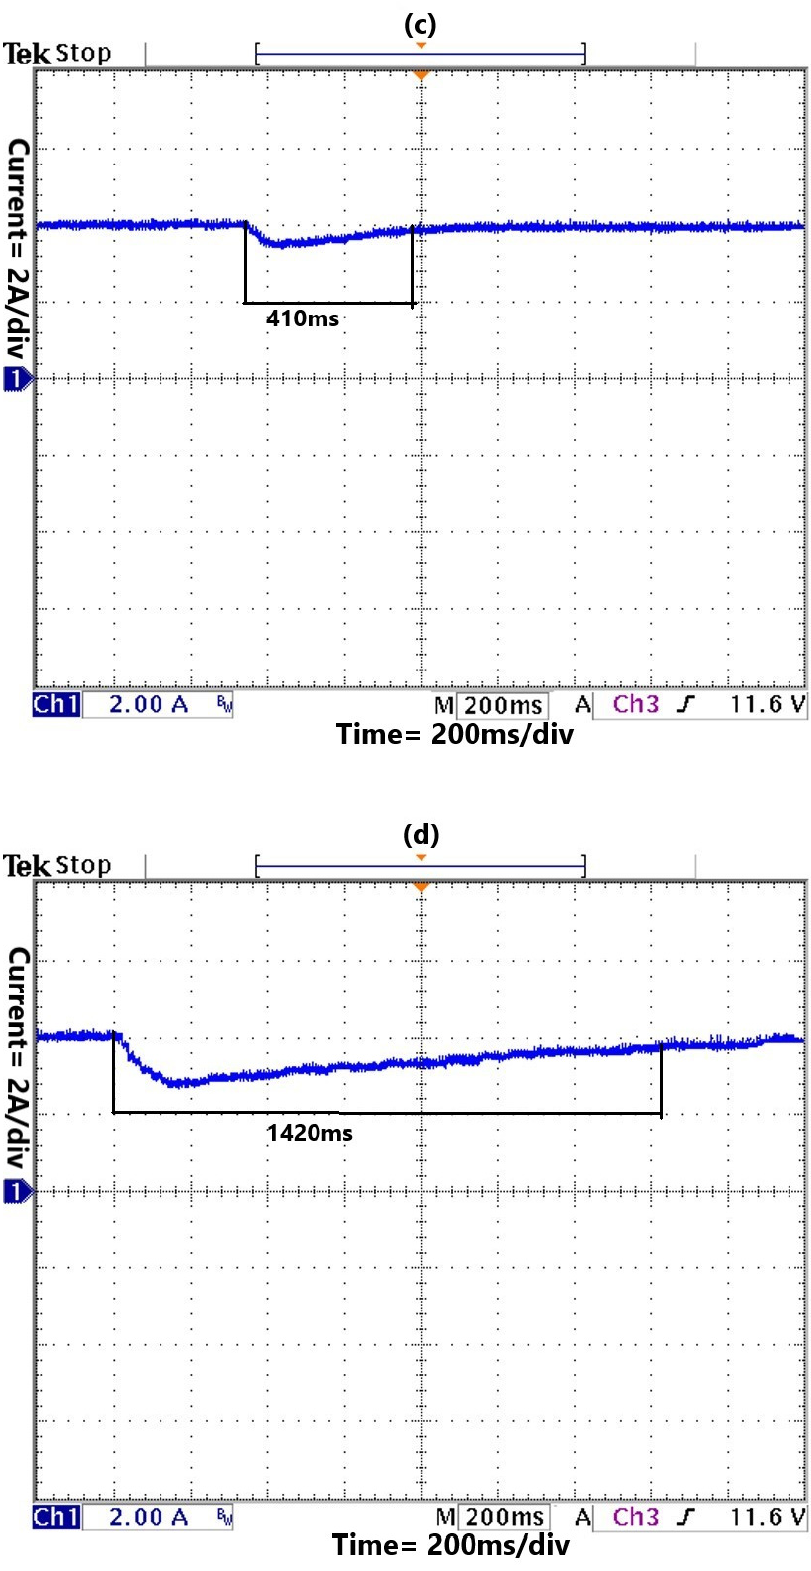
Figure 20. Experimental results when there is a 50% change in load resistance: ( a ) FCC; ( b ) LCFF; ( c ) MBPS; ( d ) PI.